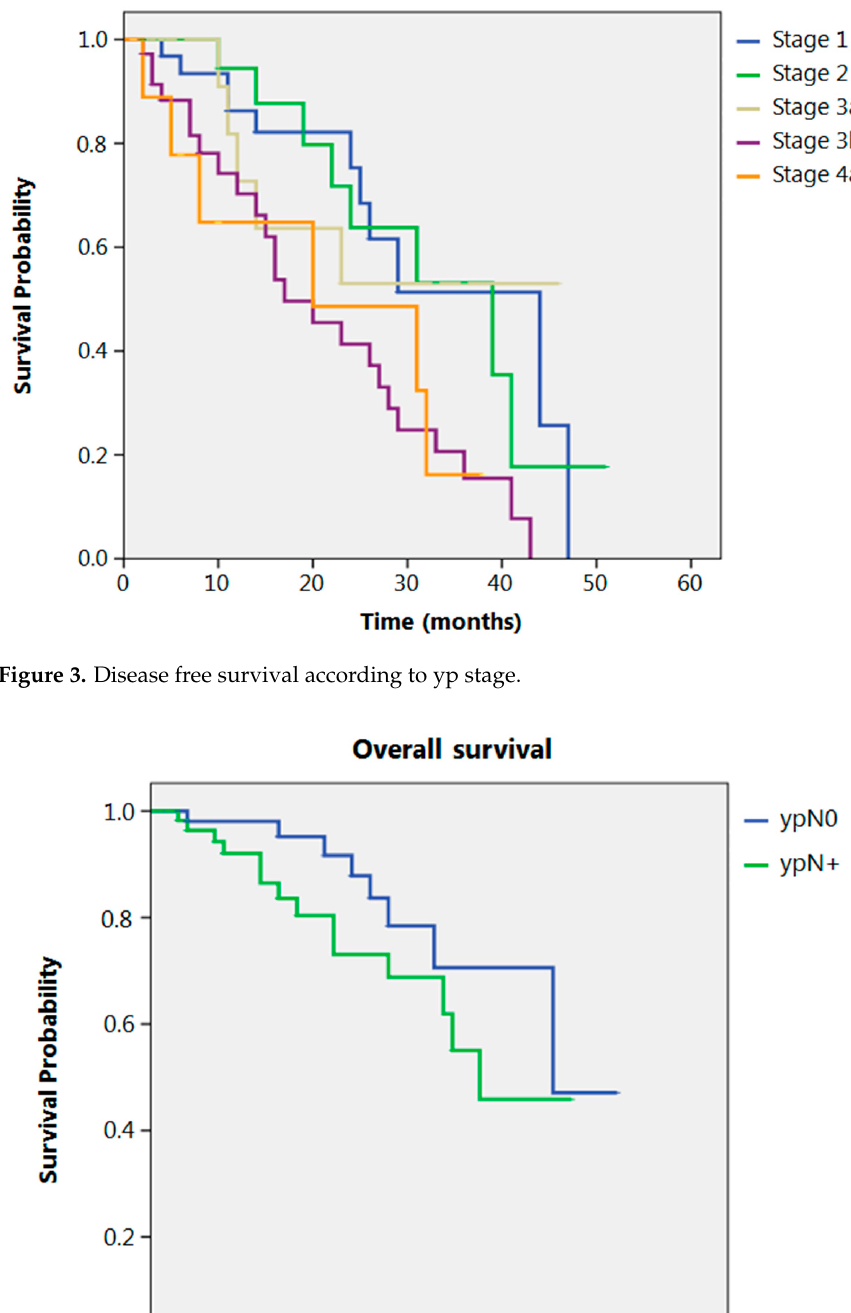
Figure 2. Overall survival according to yp stage .